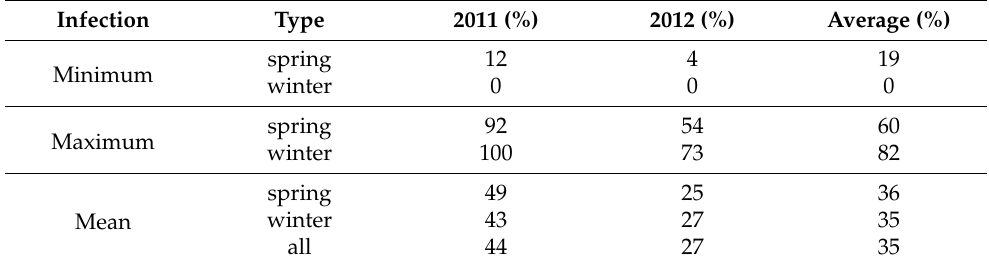
Table 1. Minimum, maximum and mean percent infection with common bunt in a collection of 248 wheat accessions. Infections are given for the years 2011 and 2012, and the average of the two years. Infection Type